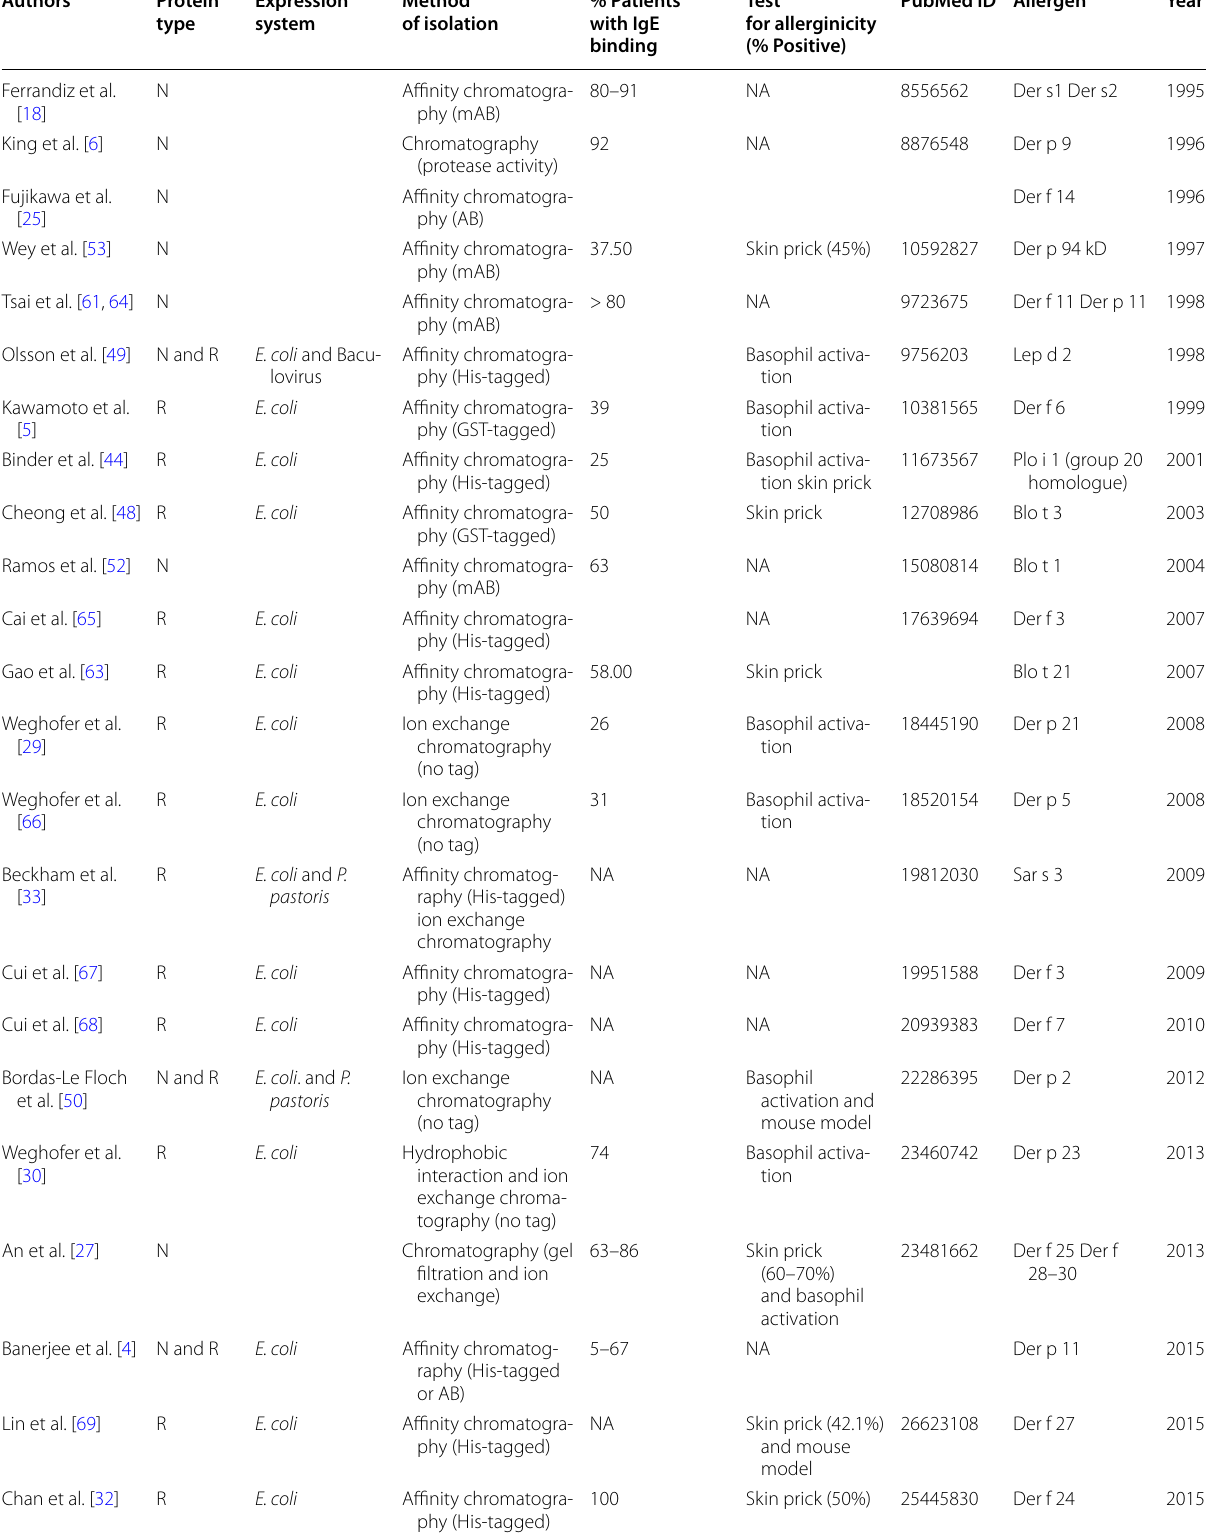
Table 2 Methods for identifying mite allergens in the confirmation